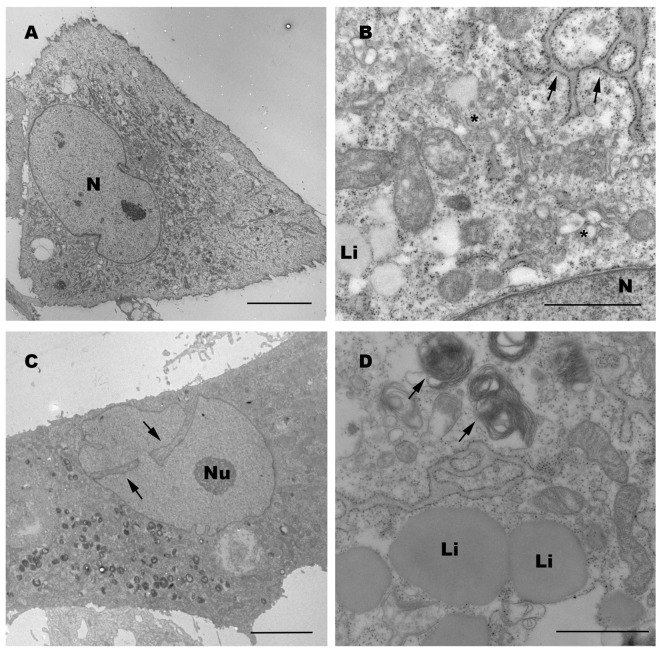
Transmission electron microscopy images of in vitro expanded ADSCs.ADSCs from cancer patients at passage 2 (A) and passage 4 (C) show cytoplasms enriched with organelles and large nucleus (N) with loosely packed chromatin. A detail of the ADSC from passage 2 (B) shows organelle enrichment, rough endoplasmic reticulum (arrows) and large Golgi cisternae (asterisk) with some lipid drops (Li). ADSCs at passage 4 (C) show prominent nuclear invaginations (arrows) and enlarged nucleoli (Nu). At low magnification also shows abundant electro-dense organelles. At a higher magnification abundant rough endoplasmic reticulum cisternae, lipid drops (Li) and abundant membranous structures or autophagosomes are appreciated (D). Scale bar 10 µm (A–C); 1 µm (B–D).